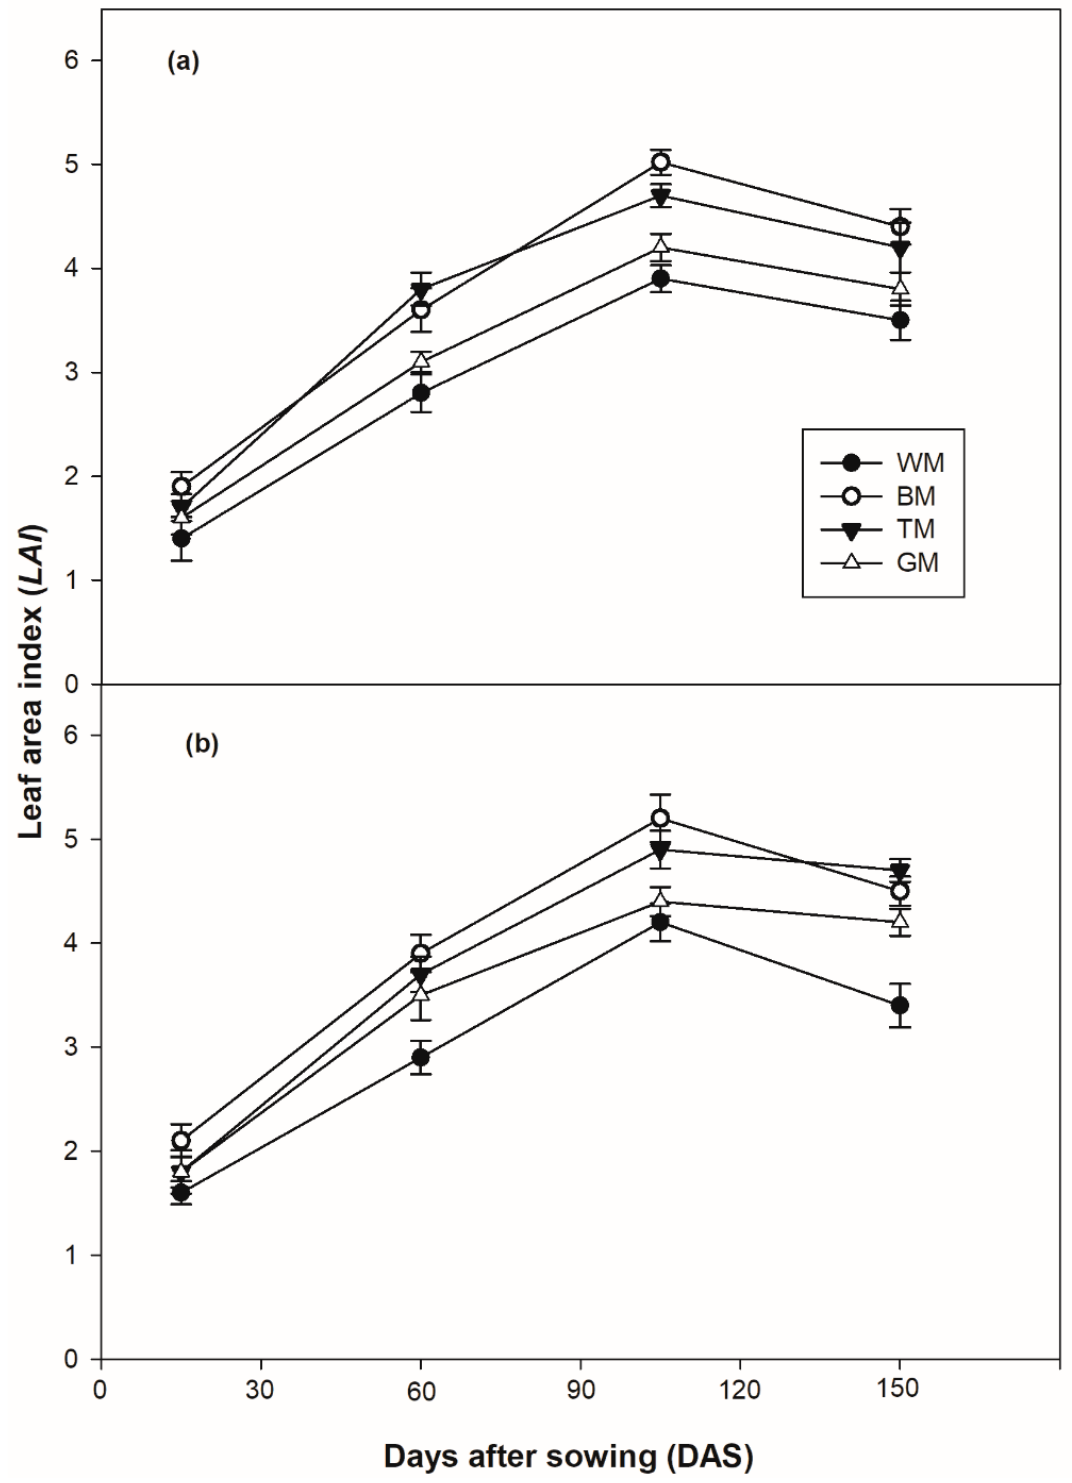
Figure 3. Leaf area index ( LAI ) of maize under ridge-furrow without mulching (WM), with black plastic mulch (BM), transparent plastic mulch (TM) and grass mulch (GM) in 2017 ( a ) and 2018 ( b ) .